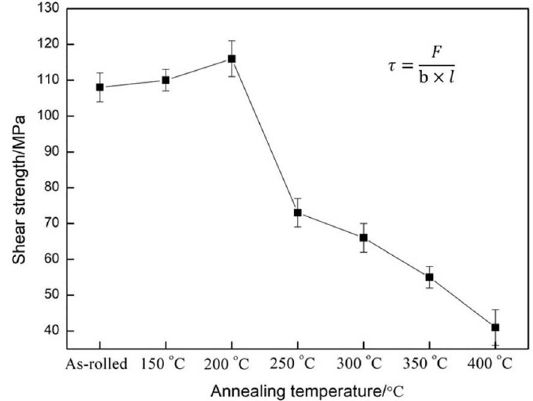
Figure 12. Shear strength under different conditions (annealed for 180